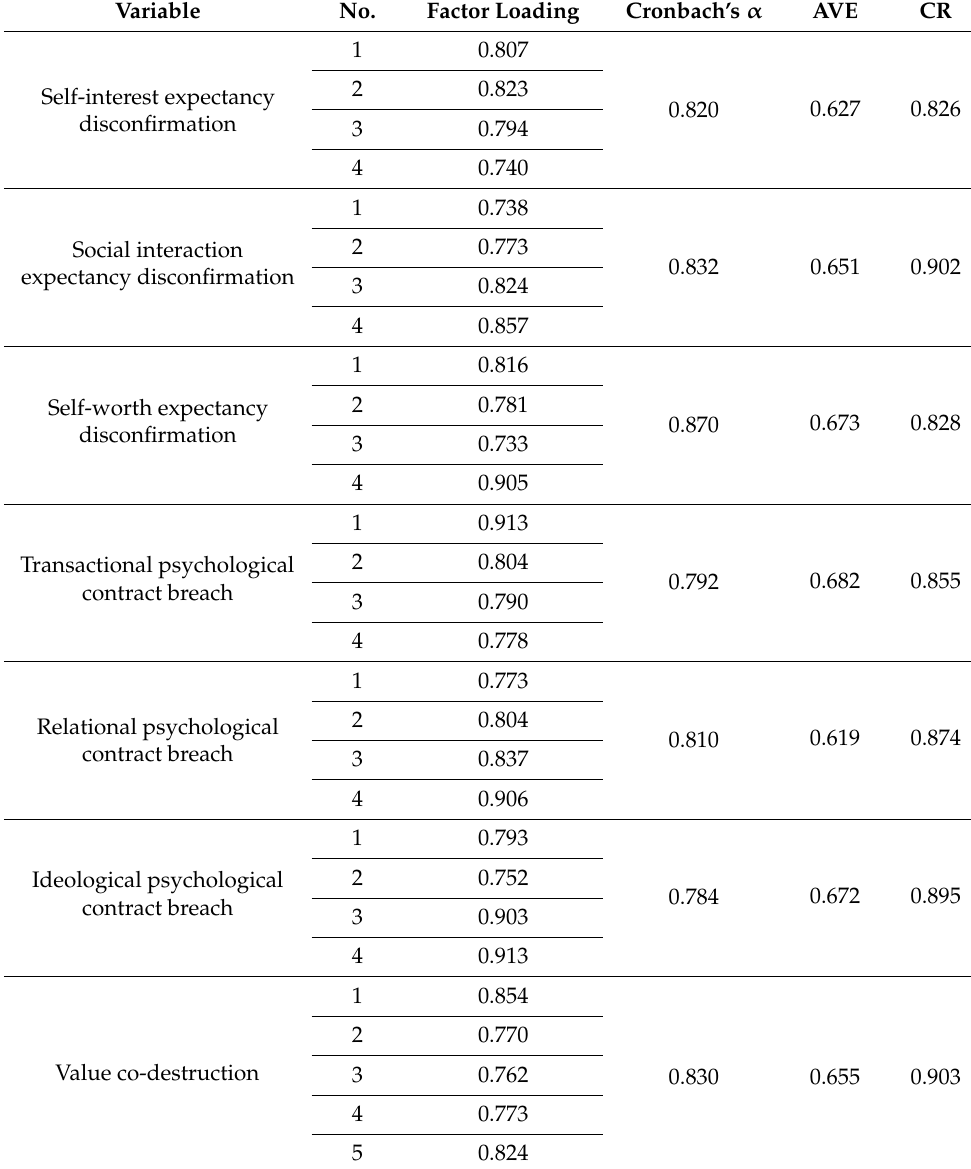
Table 3. Results of validity and reliability of the instrument and corresponding items. Variable No. Factor Loading Cronbach’s α AVE